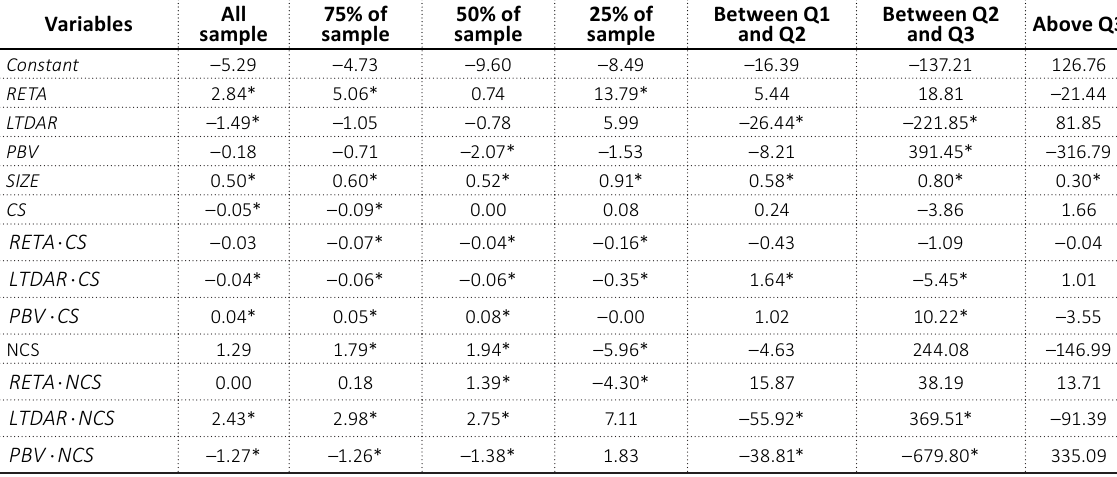
Table 4. Robustness checks on model of dividend policy on controlling and non-controlling